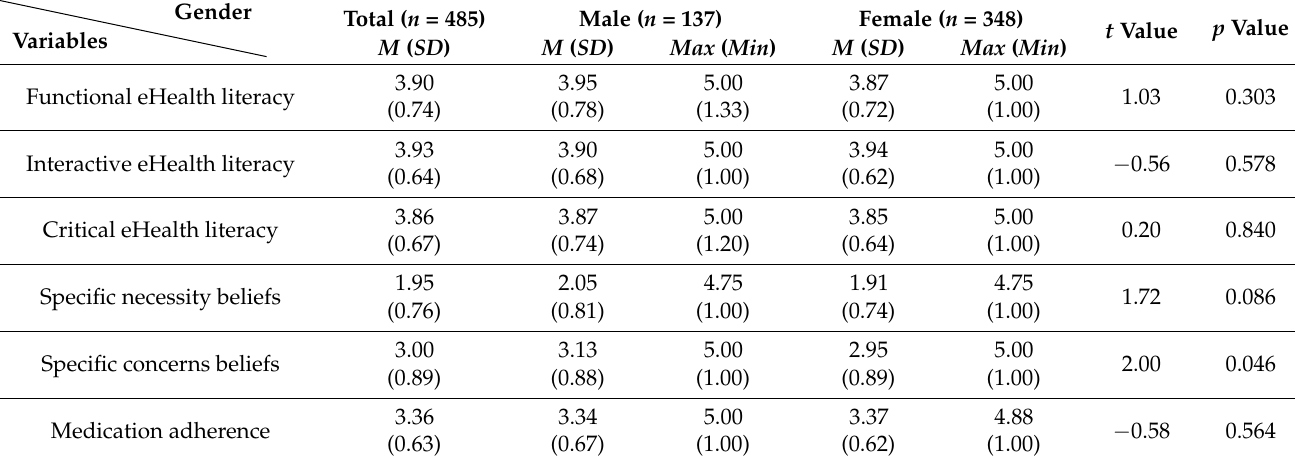
Table 1. Overview of the mean (and standard deviation in parentheses) and max (and min in parentheses) values and independent t test results of the participant characteristics, with stratification by